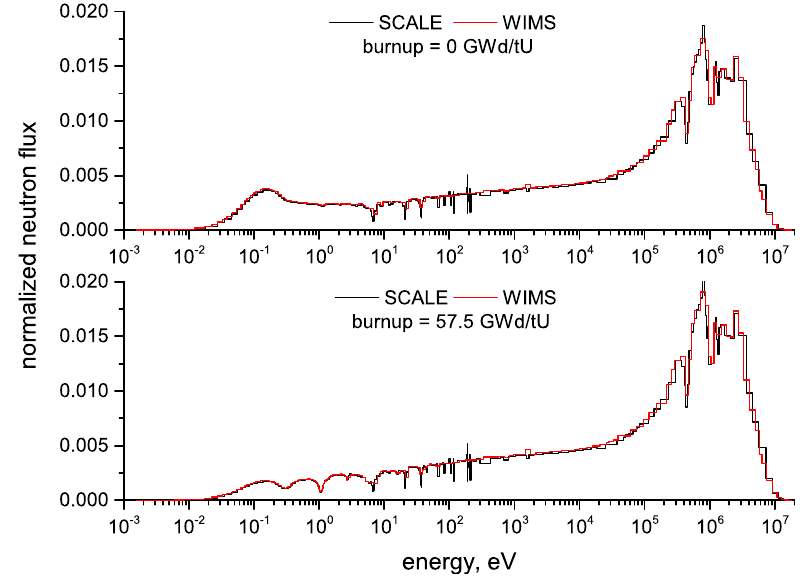
Figure 9. Flux distribution over neutron energy for the BWR pin-cell model in SCALE-6.2 (252 energy groups) and WIMS-10A (172 energy groups) for the BoL and EoL.